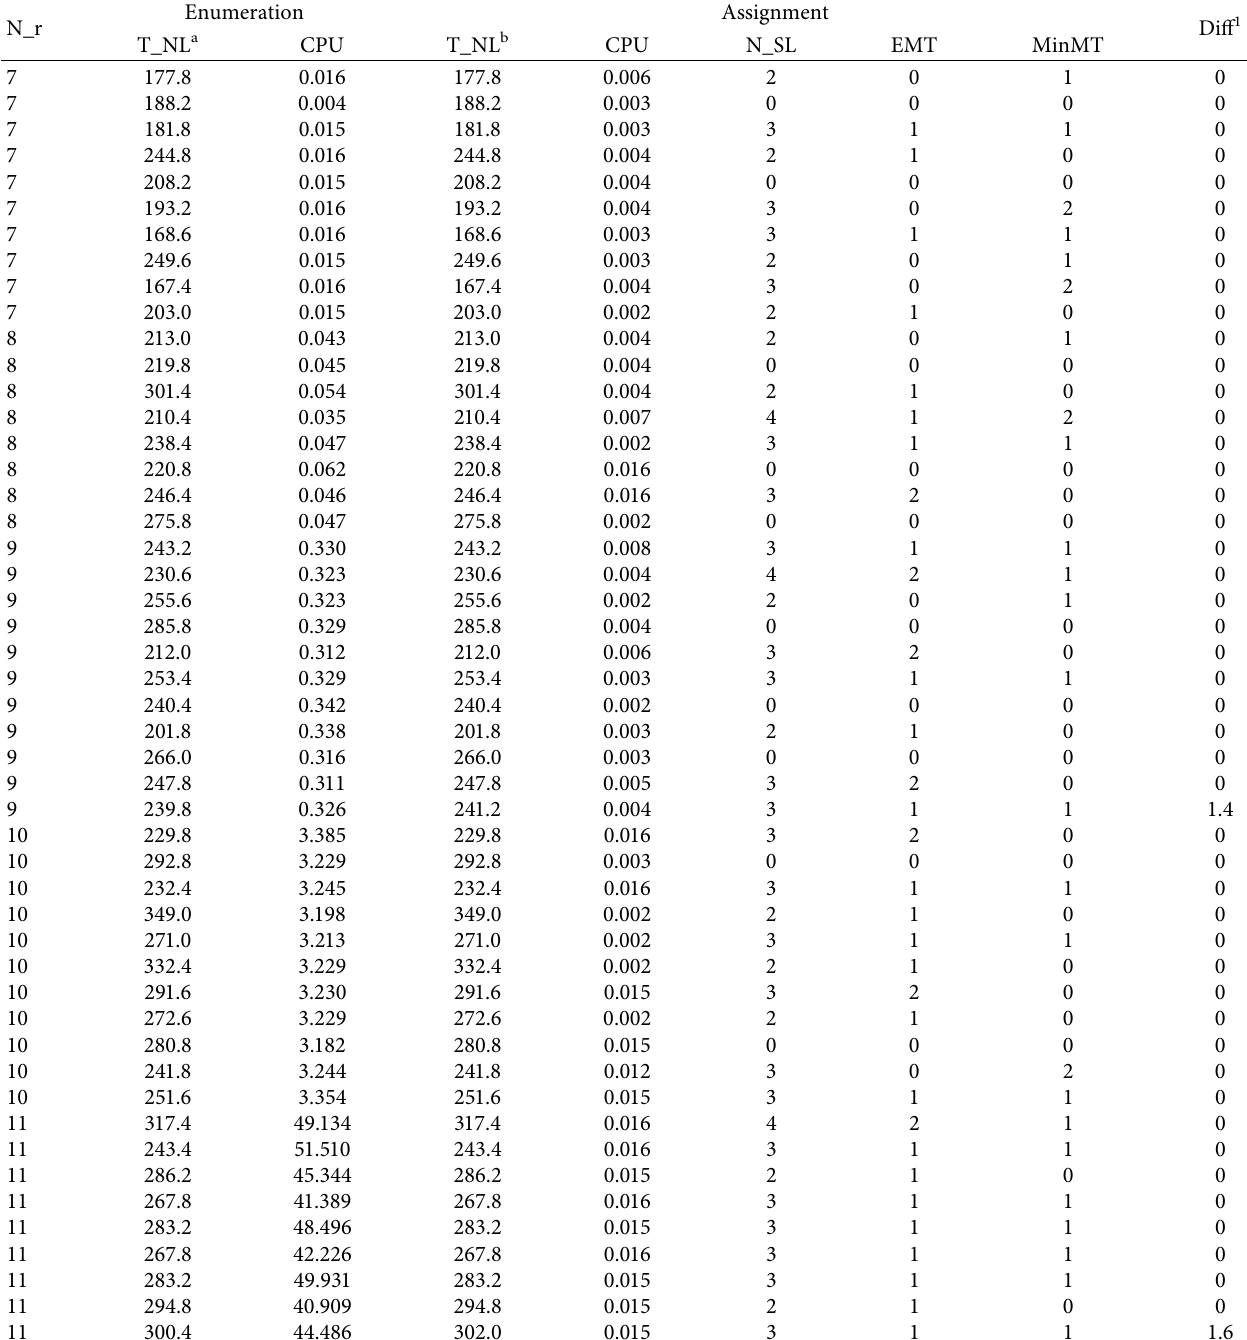
Table 4: Comparisons of unload times between EA and proposed method for small-scale